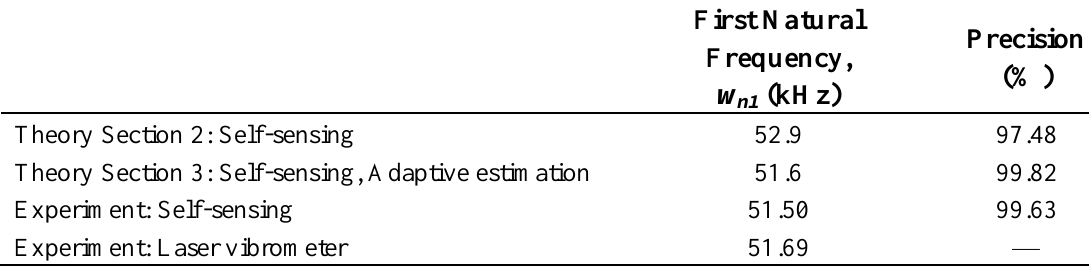
Table 2. Comparing the results obtained from mathematical modeling presented in parts I and II with the experimental